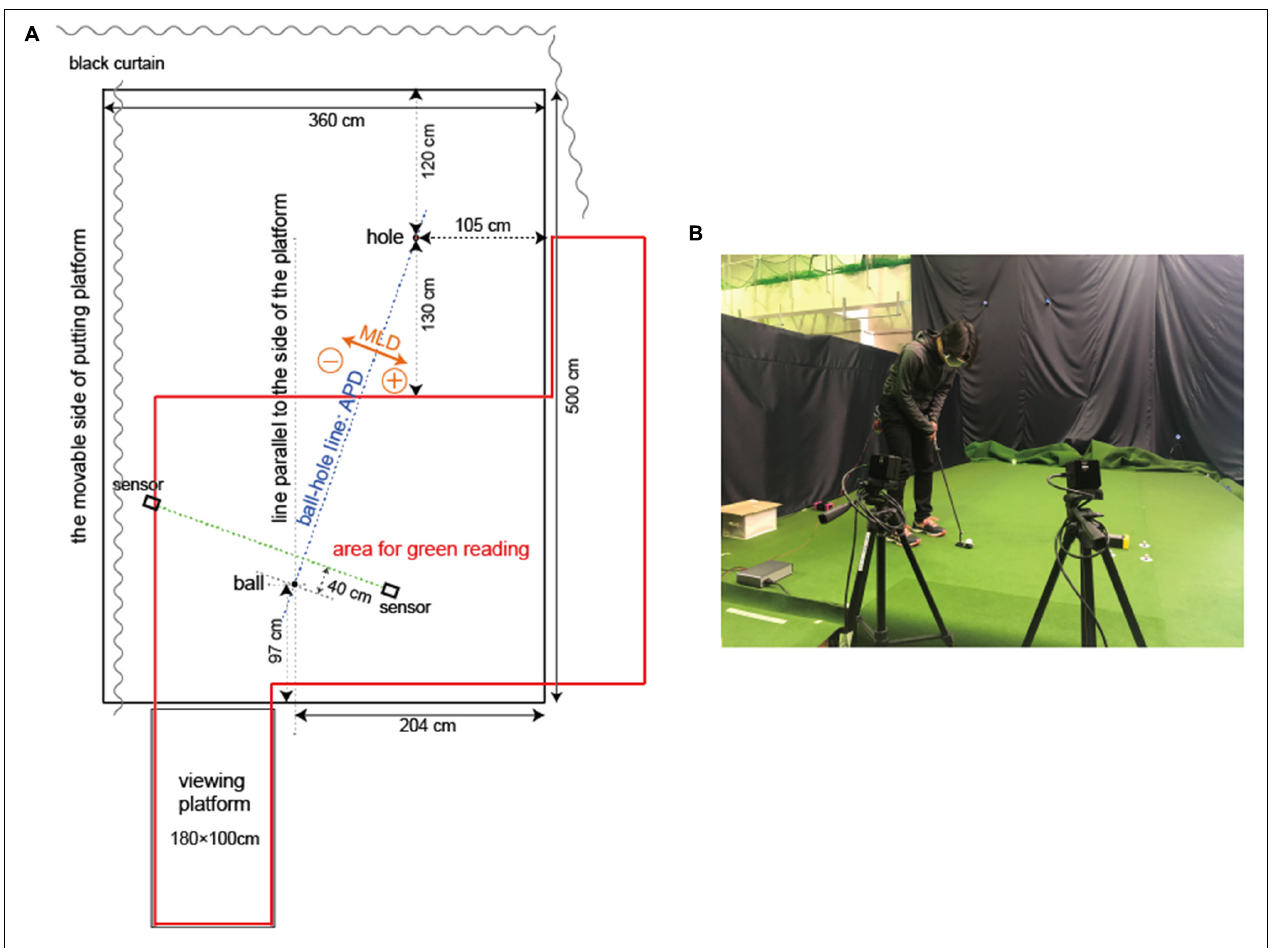
FIGURE 1 | Experiment setting: (A) represents the pattern diagram of the experiment setting, while (B) shows a participant wearing shielded goggles for measurement. The experiment area where the putting platform was set was surrounded by curtains, and care was taken not to give the participants reference frames. The area surrounded by the red line indicates where participants could move freely to read the green. Two sensors were placed so that the shutter goggles would be activated when the ball passed the line 40 cm in front of where it was set. APD, anteroposterior direction; MLD, mediolateral